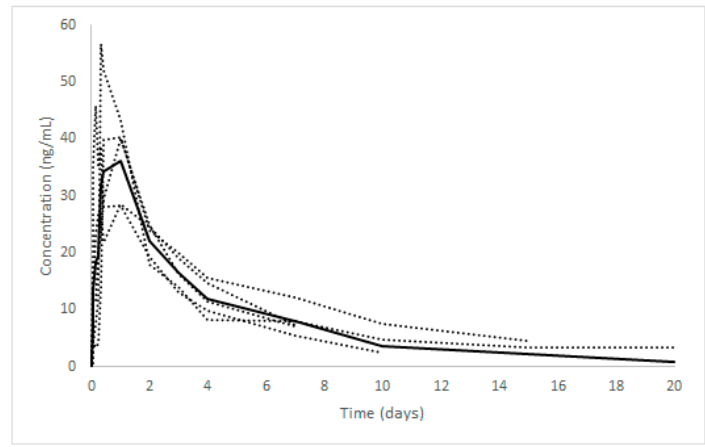
Figure 1. Average (solid line) and single (dot lines) IVM serum concentrations vs. time after oral administration at a dose of 200µg/kg BW in mules ( n = 5).